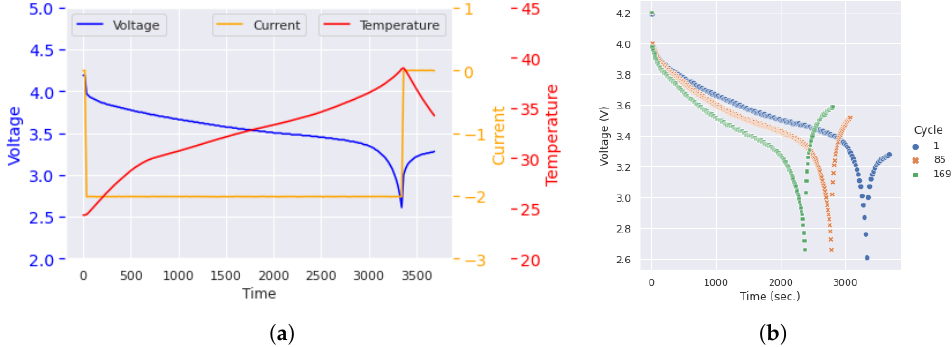
Figure 4. All possible parameters. ( a ) Discharge voltage, current and temperature profile from fresh cell. ( b ) Voltage discharge profile at different cycles from